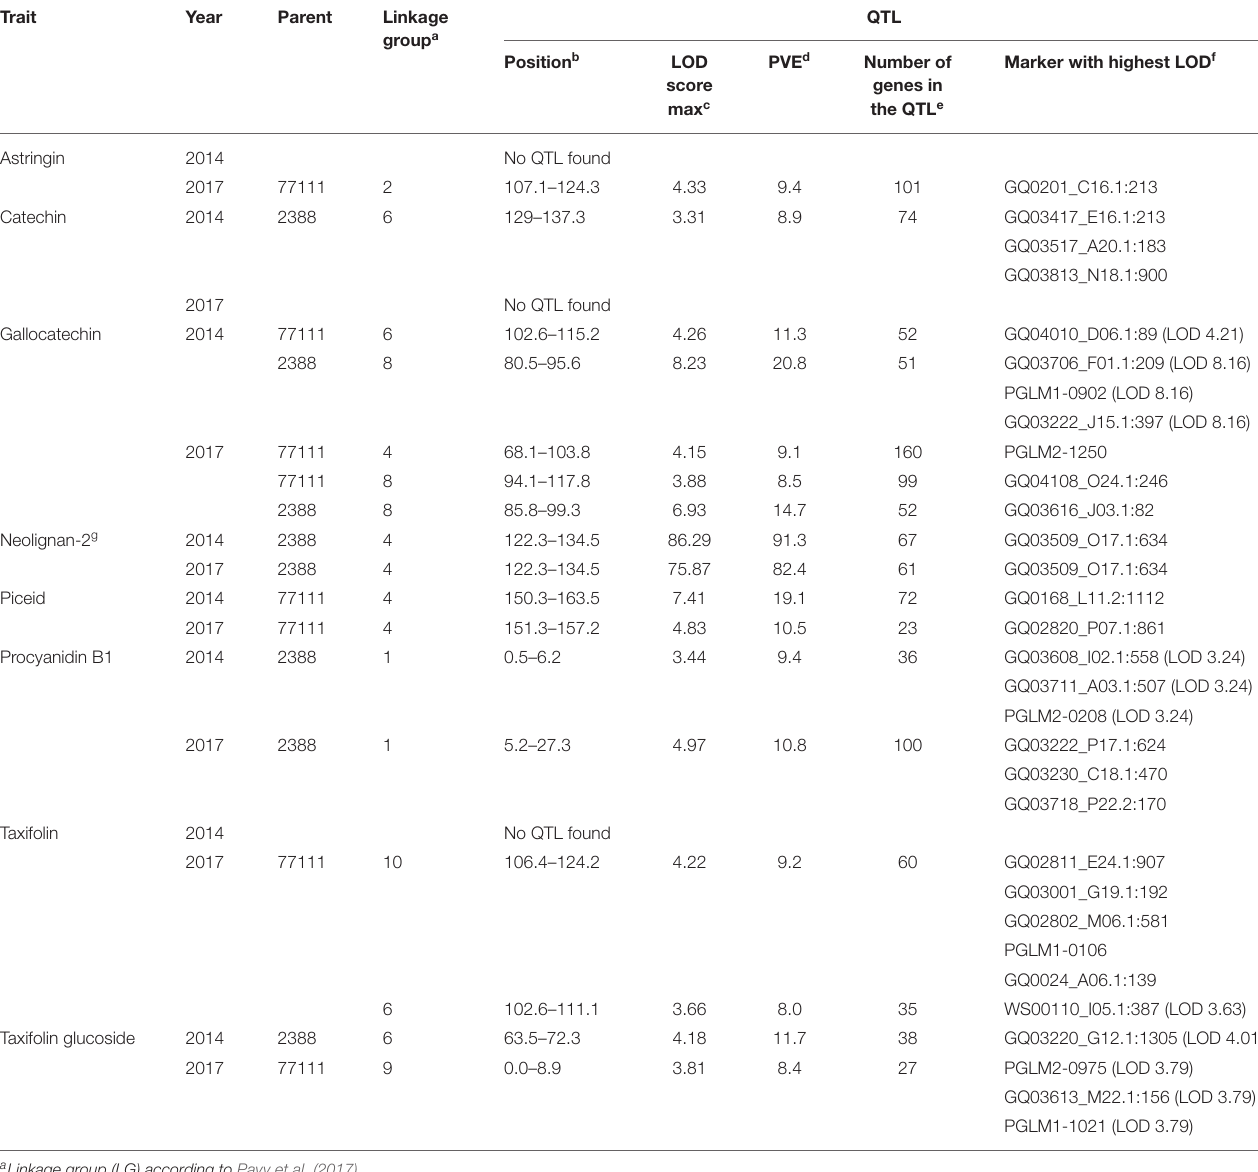
TABLE 2 | Summary statistics of significant QTLs (LOD score > 3.1) detected for eight phenolic compounds in the C94-1-2516 white spruce full-sib family in 2014 and 2017.